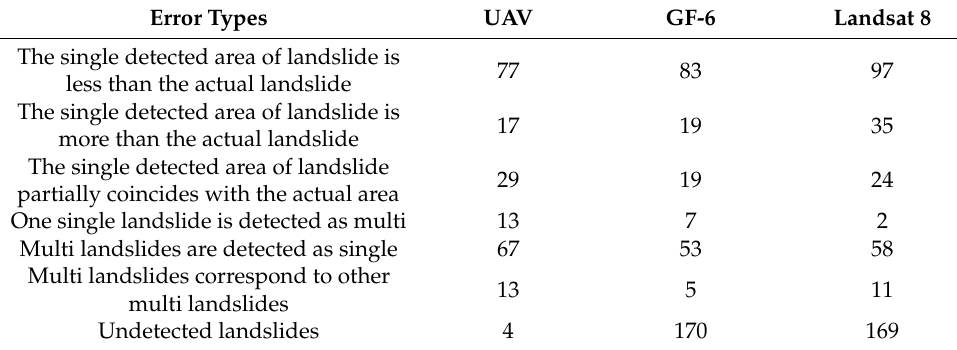
Figure 8. The type of automatic detection errors. ( a ) The landslide detection area in black line is smaller than the actual area in red. ( b ) The landslide detection area is larger than the actual area. ( c ) The detected area of the landslide partially coincides with the actual area. ( d ) A landslide is detected as multiple landslides. ( e ) Multiple landslides are detected as a single landslide. ( f ) Multiple landslides are detected as multiple landslides. Table 5. Types of automatic detection errors in remote sensing